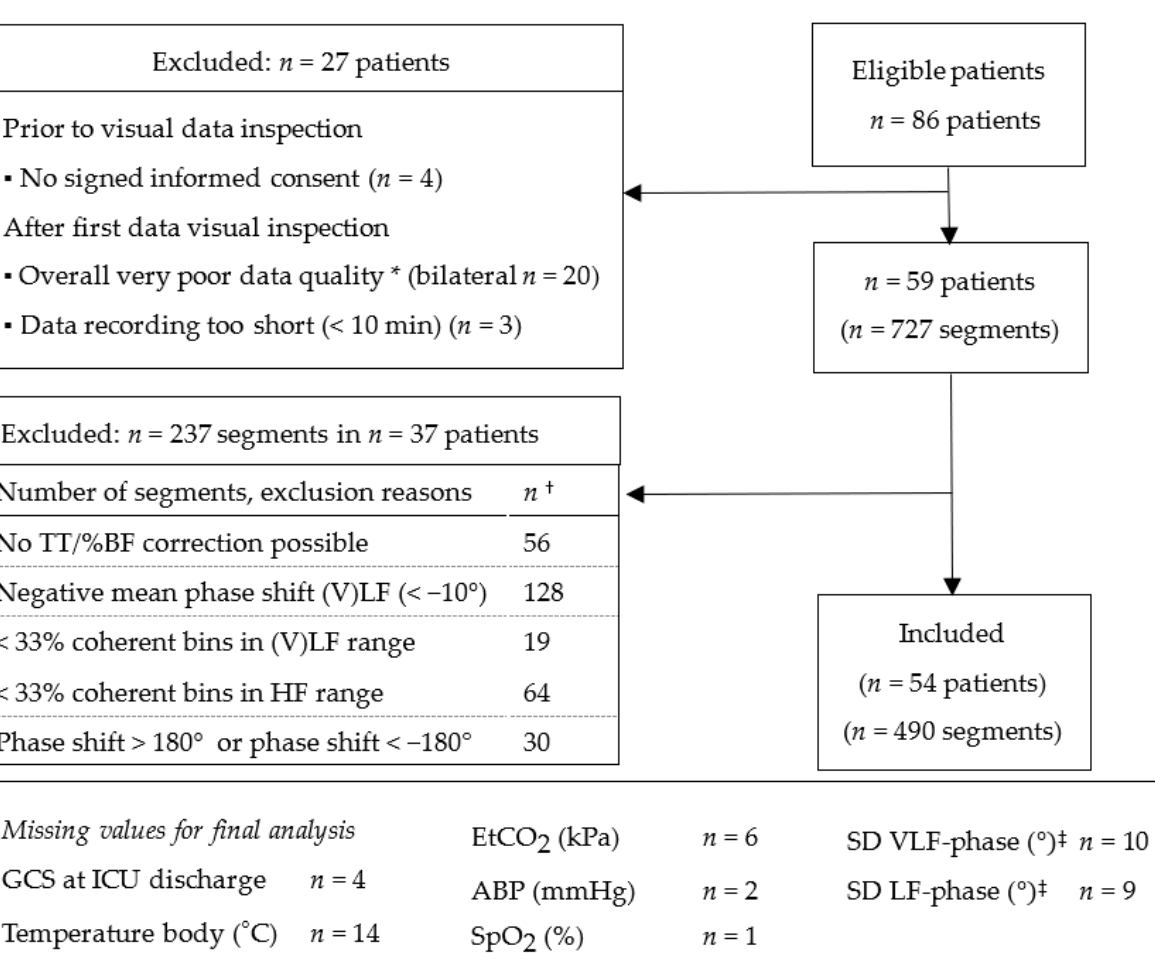
Figure 1. Study flow chart. Each box (right side) shows the remaining number of patients and remaining number of segments. For each patient a different number of segments is available. * Overall poor data quality e.g., crosstalk, no beat-to-beat pulsatility, multiple-artifacts. † The numbers do not count to the number of ‘excluded’ segments, because each segment can have more than one reason for exclusion. ‡ No SD could be calculated, as the patient is represented by only one segment. ABP = arterial blood pressure; BF = blood flow oscillations; EtCO 2 = end tidal carbon dioxide; GCS = Glasgow coma scale; HF = high frequency range; (V) LF = (very) low frequency range; SD = standard deviation; SpO 2 = peripheral oxygen saturation; TFA = transfer function analysis; TT = microvascular transit time. Table 2. Patient characteristics dichotomized for six-month mortality .